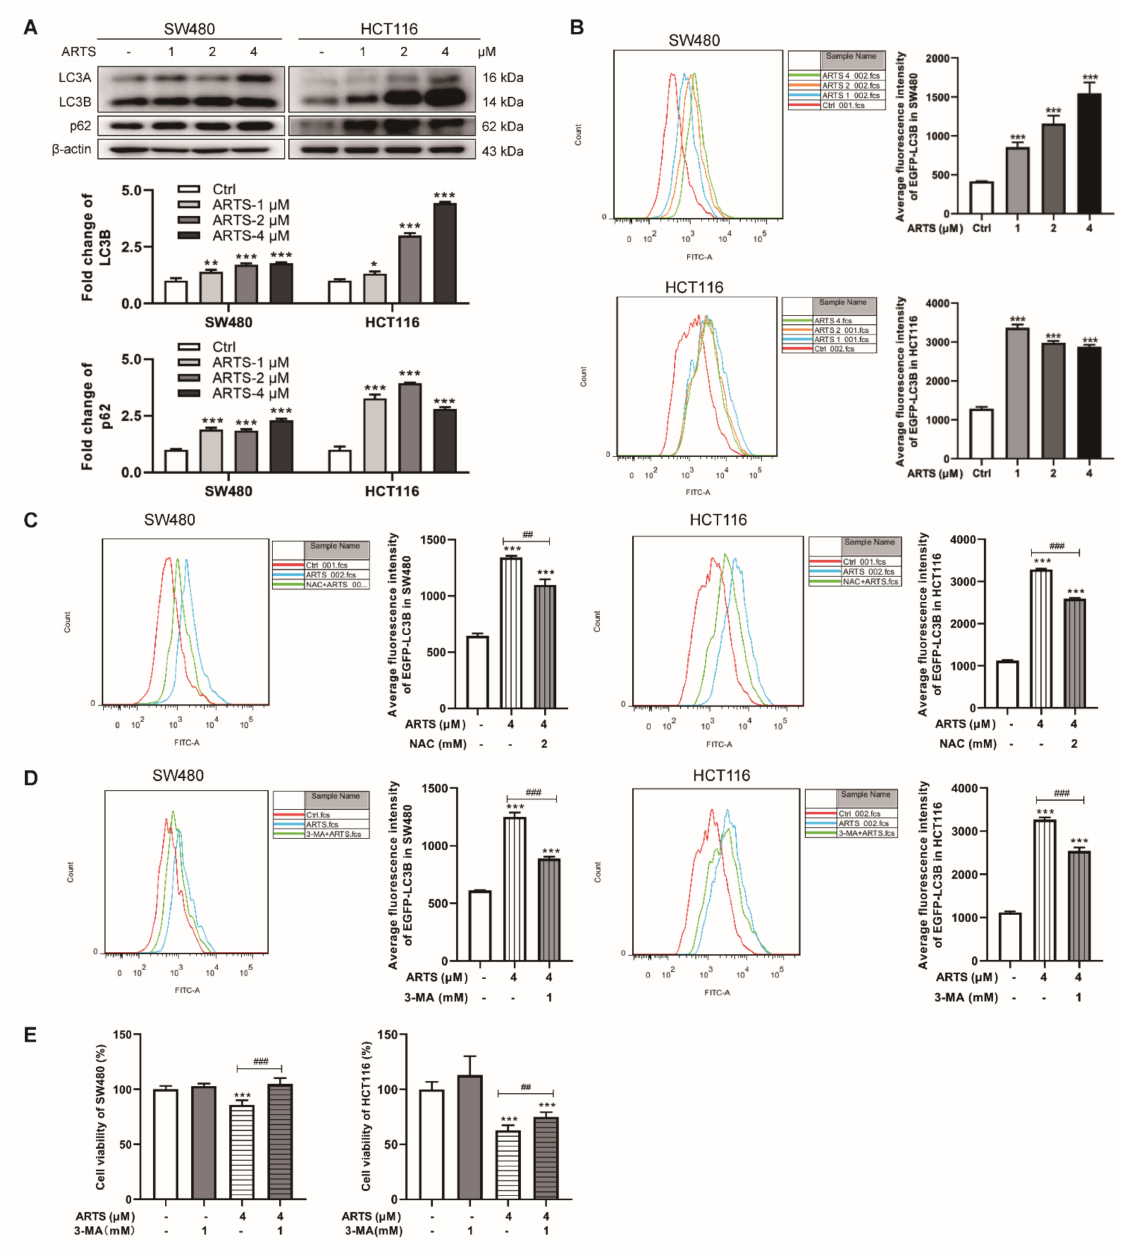
Figure 5. Artesunate caused autophagy to inhibit cell proliferation ROS-dependently. ( A ) Artesunate upregulated the expression levels of LC3B and p62. Cells were seeded in 60 mm dishes and treated with artesuante (1, 2, 4 µ M) for 72 h. Then, cells were lysed with RIPA to extract total protein. The protein levels were measured by western blotting. The gray values of protein blots were evaluated by Image J. Relative protein expression was normalized to β -actin. ( B ) Artesunate induced the expression of exogenous LC3B. SW480 and HCT116 were transfected with pEGFP-LC3B-C1 plasmid and then treated with artesunate (1, 2, and 4 µ M) for 72 h. The fluorescence intensity of EGFP, which was analyzed by flow cytometry, represented the expression level of exogenous LC3B. ( C ) NAC helped to reduce the fluorescence intensity of EGFP. 3-MA was used at a concentration of 1 µ M and added alone or together with artesunate (4 µ M) for 72 h. 3-MA, an autophagy inhibitor, helped to ( D ) reduced the fluorescence intensity of EGFP and ( E ) restore cell viabilities of SW480 and HCT116. * p < 0.05, ** p < 0.01, and *** p < 0.001 vs. Ctrl. ## p < 0.01, and ### p < 0.001 vs. cells treated with artesunate alone. Data were shown as mean ±